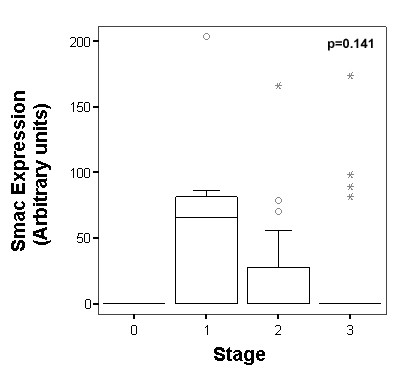
Smac expression levels versus clinical stage of cervical cancer samples. Graph shows median, upper and lower quartiles. P value testing the significance of the difference by ANOVA.